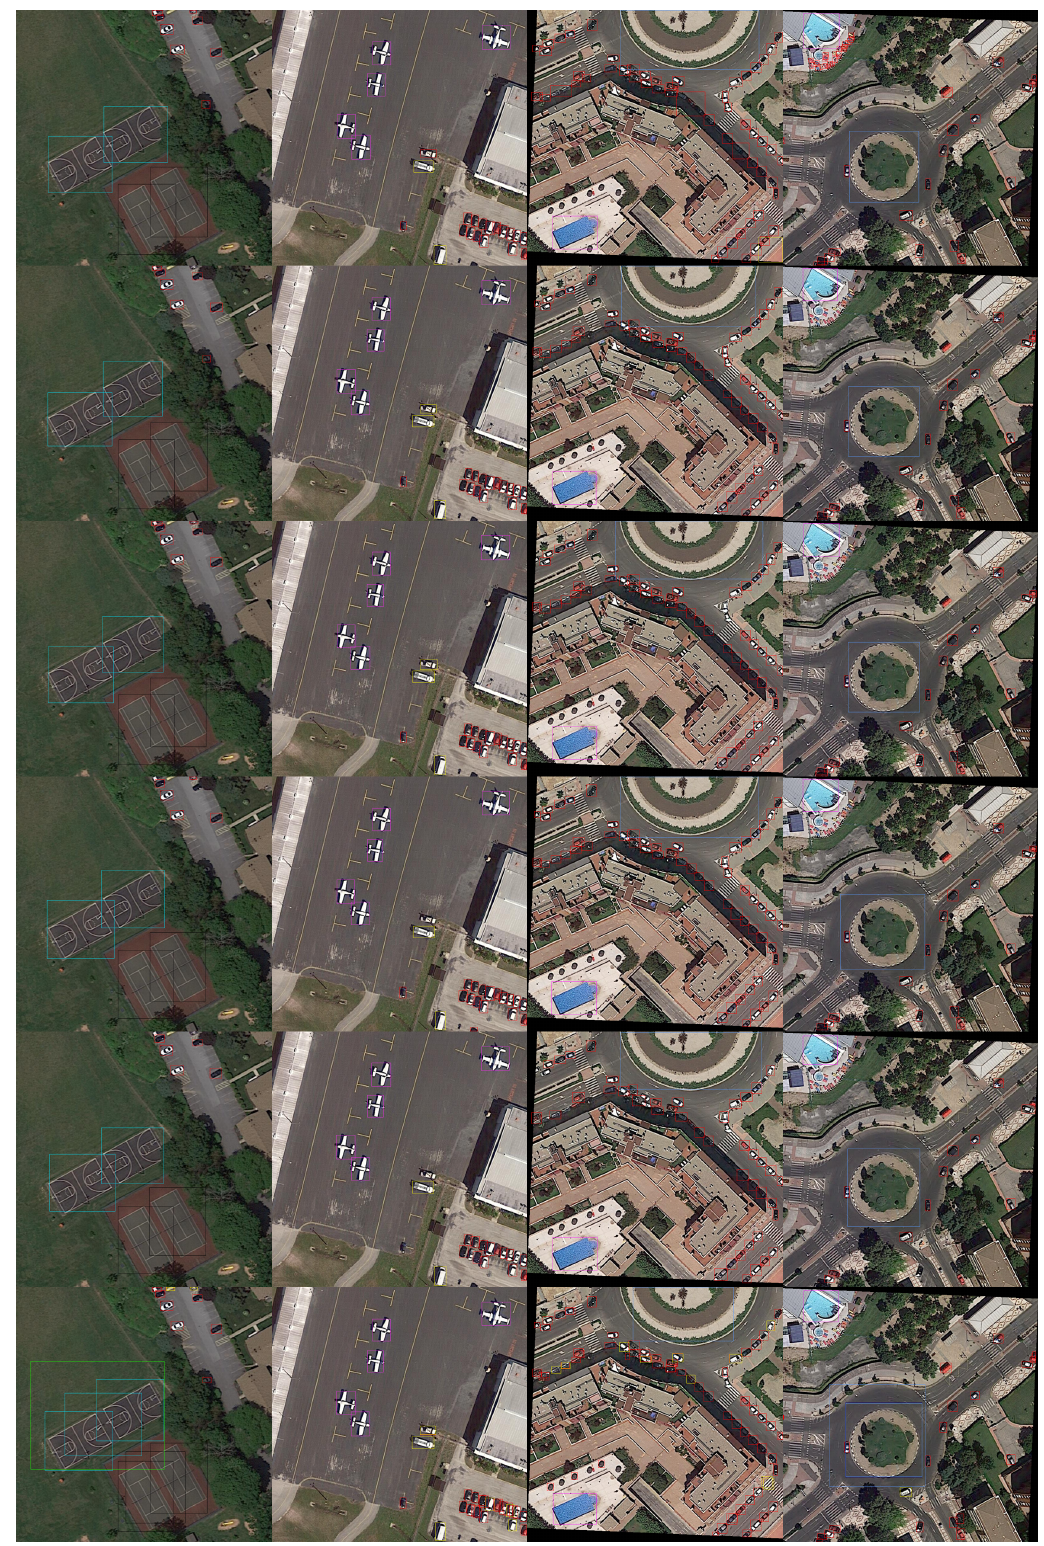
Figure 7. Qualitative results of our 15 FPS model ( second row ), 30 FPS model ( third row ), 60 FPS model ( fourth row ) and 90 FPS model ( fifth row ) compared to RetinaNet ( bottom row ) and ground truth annotations ( top row ). These results approve the quantitative results with the faster models dropping in accuracy because of more missed objects. While RetinaNet does not miss many objects, it outputs many false positive predictions which leads to its poor quantitative